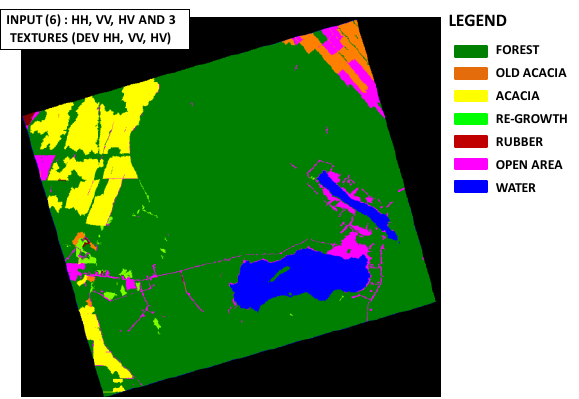
Figure 8. Land cover classification using 10 spatial resolution with 3 polarization images and 3 texture images (Object-based)